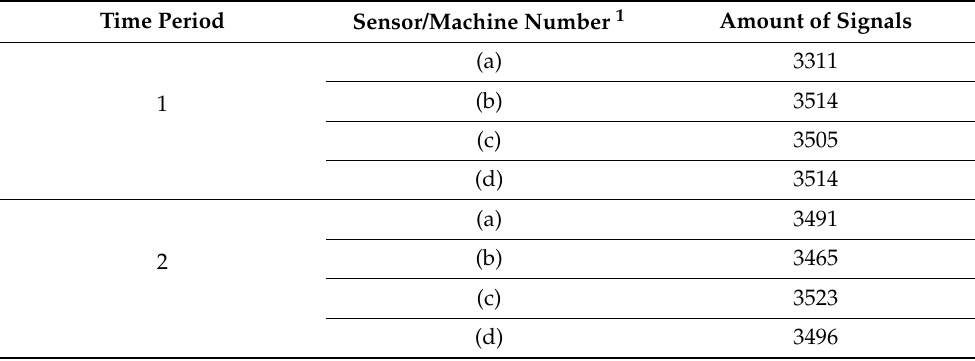
Table 3. The validation results for the machine utilization abstracting neural